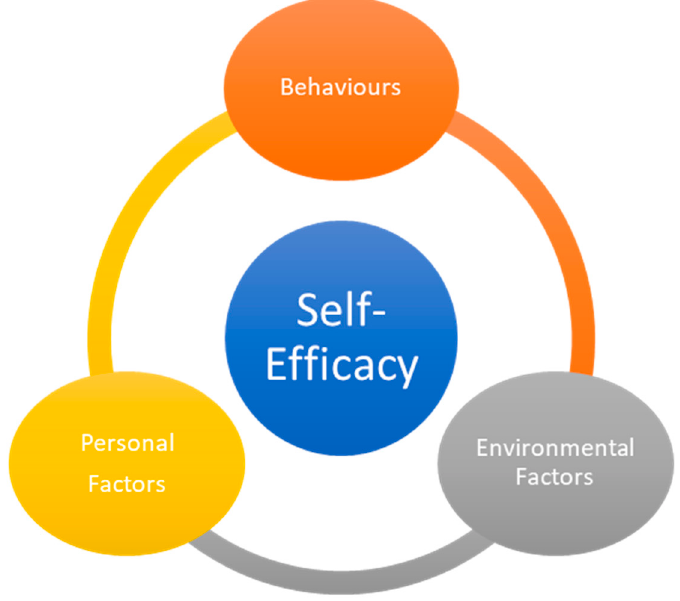
Figure 1. The triadic reciprocality.